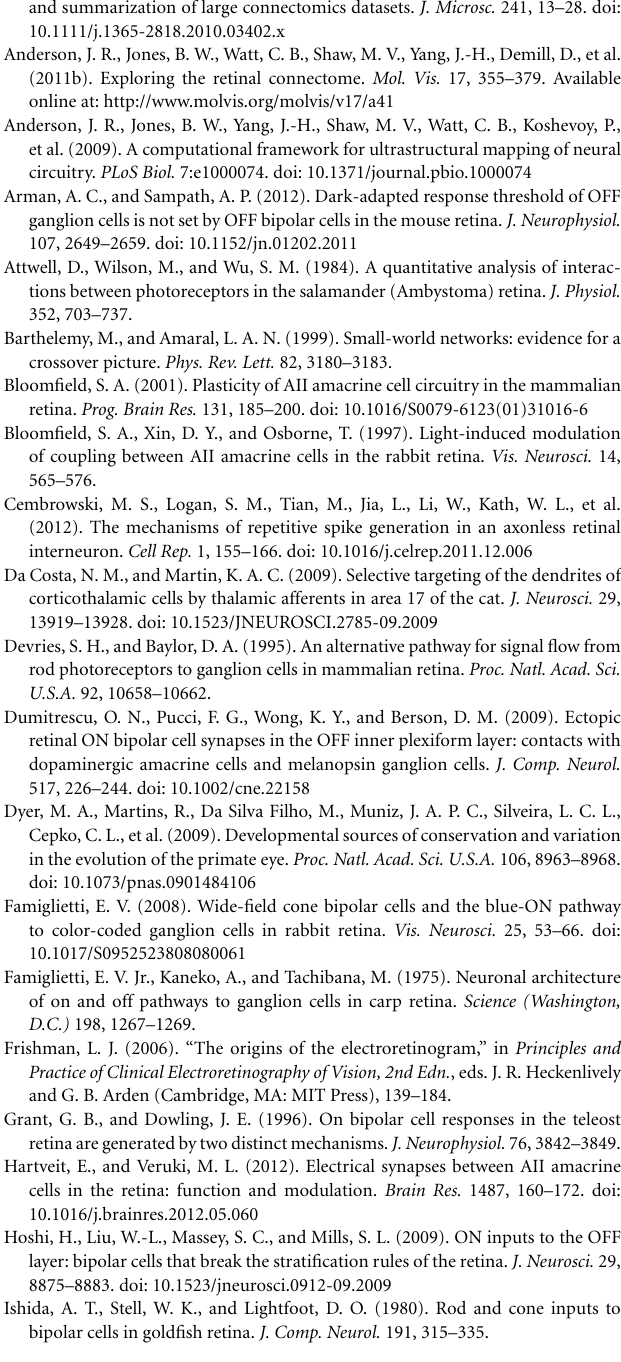
Table S1 | A comprehensive list of all AII amacrine cell partnerships.